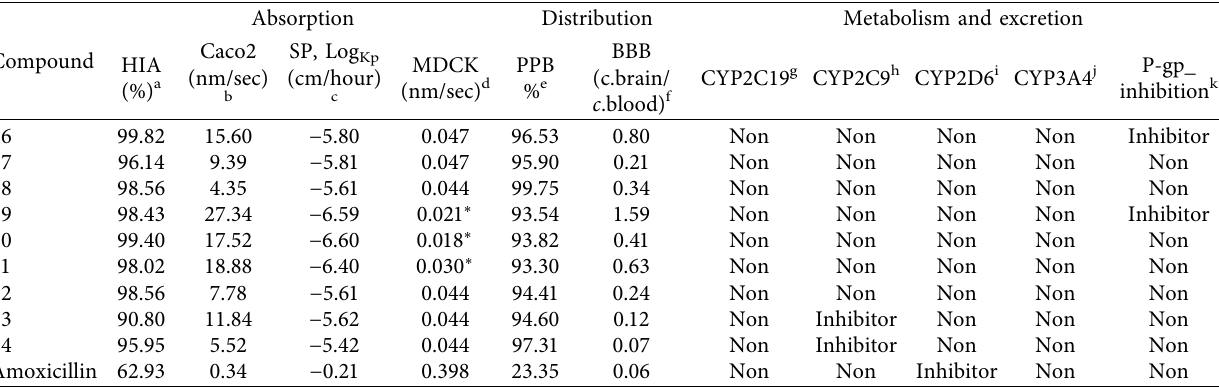
Table 4: Pharmacokinetic (ADME) property prediction of compounds (16–24) and amoxicillin using PreADMET online server. Absorption Distribution Compound